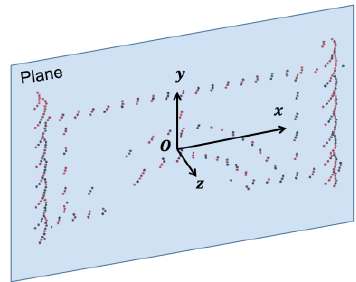
Figure 12. Superimposing points of unit shapes